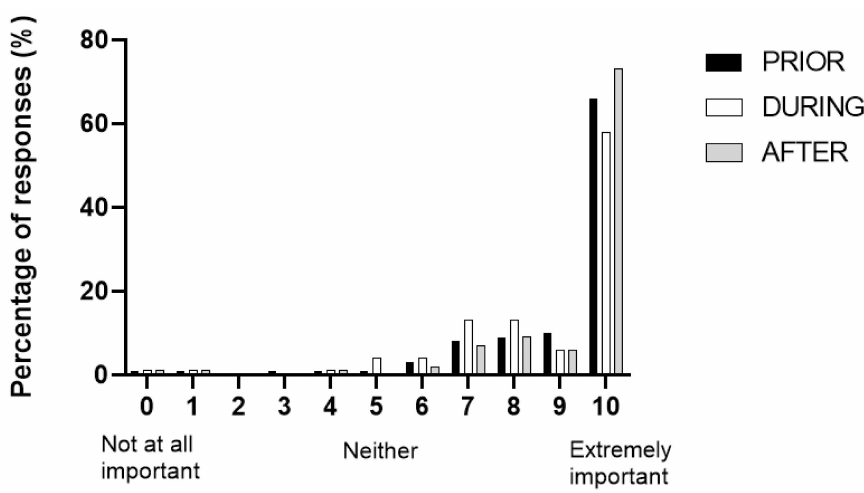
Figure 2. Ratings of importance of hydration prior to, during and after a triathlon event by parents of children participating in a Triathlon Victoria event in Melbourne.